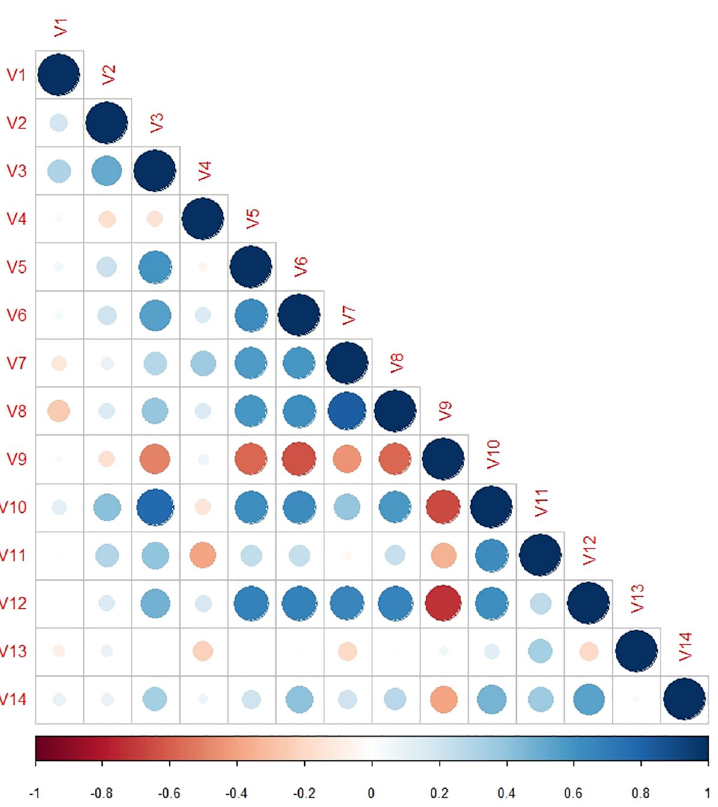
Fig 2. Correlation matrix of predictor variables for consistently high HIV prevalence at the district level in India. Size and colour density of circles are proportional to correlation between two variables. V1—Population size, V2- Population density, V3—Proportion of urban population, V4—Sex ratio, V5—Proportion population between 15–49 years, V6—Total literacy rate, V7—Mean age of marriage (males), V8- Mean age of marriage (females), V9 – Proportion of households with low standard of living, V10 –Proportion of households with high standard of living, V11—Use of condom as method of contraception, V12—Proportion of females heard of HIV/AIDS, V13—Proportion of women who knew that consistent condom use can reduce the chances of getting HIV/AIDS, V14—Proportion of females heard of RTI/STIs. (HIV, human immunodeficiency virus; AIDS, acquired immunodeficiency syndrome; RTI, reproductive tract infection; STI, sexually transmitted